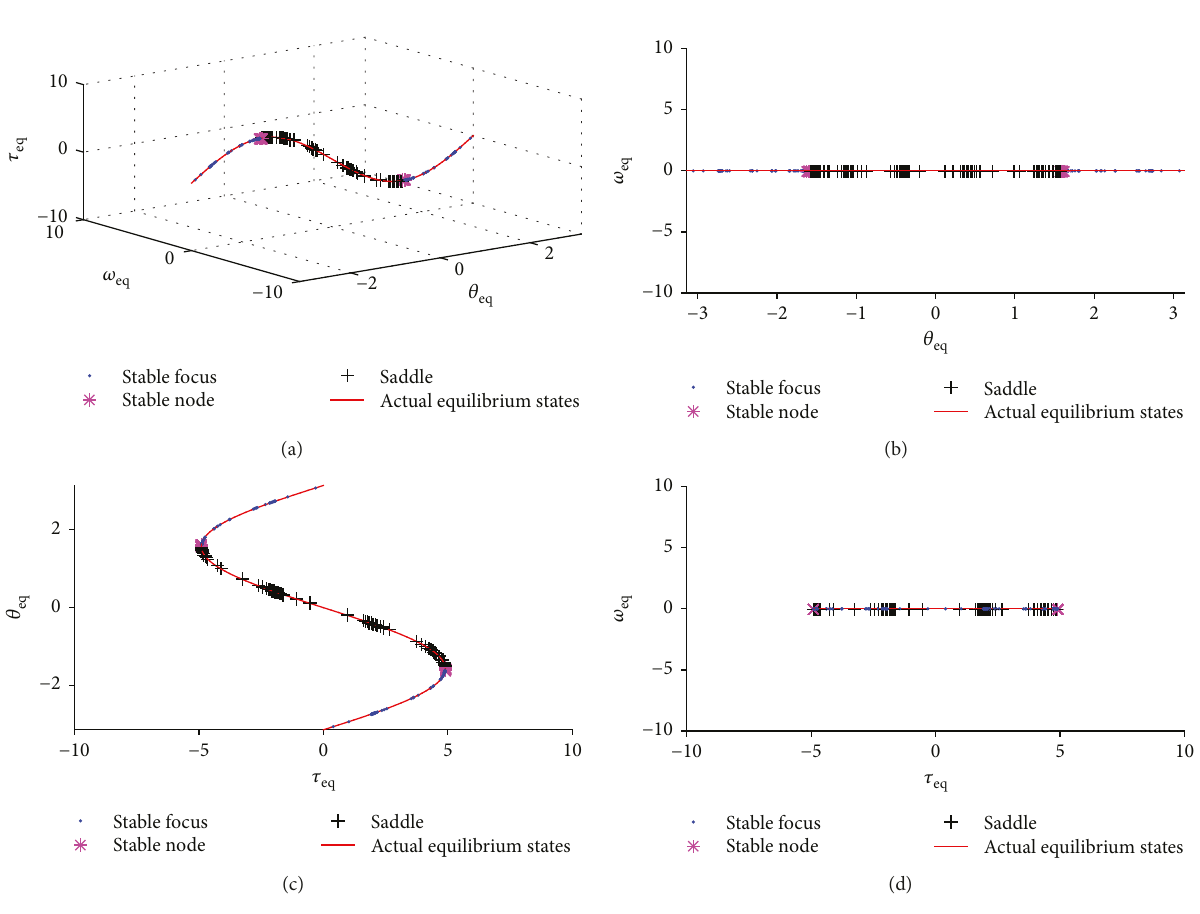
Figure 5: Equilibrium states of the inverted pendulum with